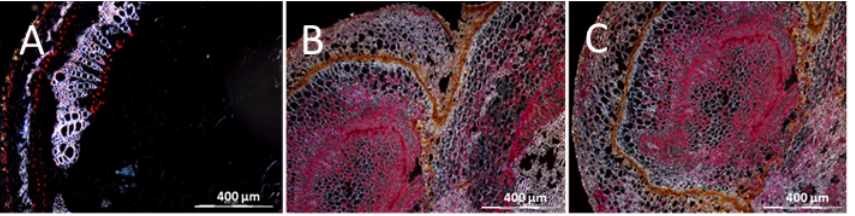
Figure 10. Distribution of CBSV-Mo83 RNA in cross sections from DSC 260 and TMS 96/0304 buds. ( A ) Red signals in DSC 260 bud tissues, restricted to phloem and cortical cells only. ( B , C ) Strong signals dispersed over all cell types indicate highly abundant viral RNA in buds of the susceptible cassava TMS 96/0304.